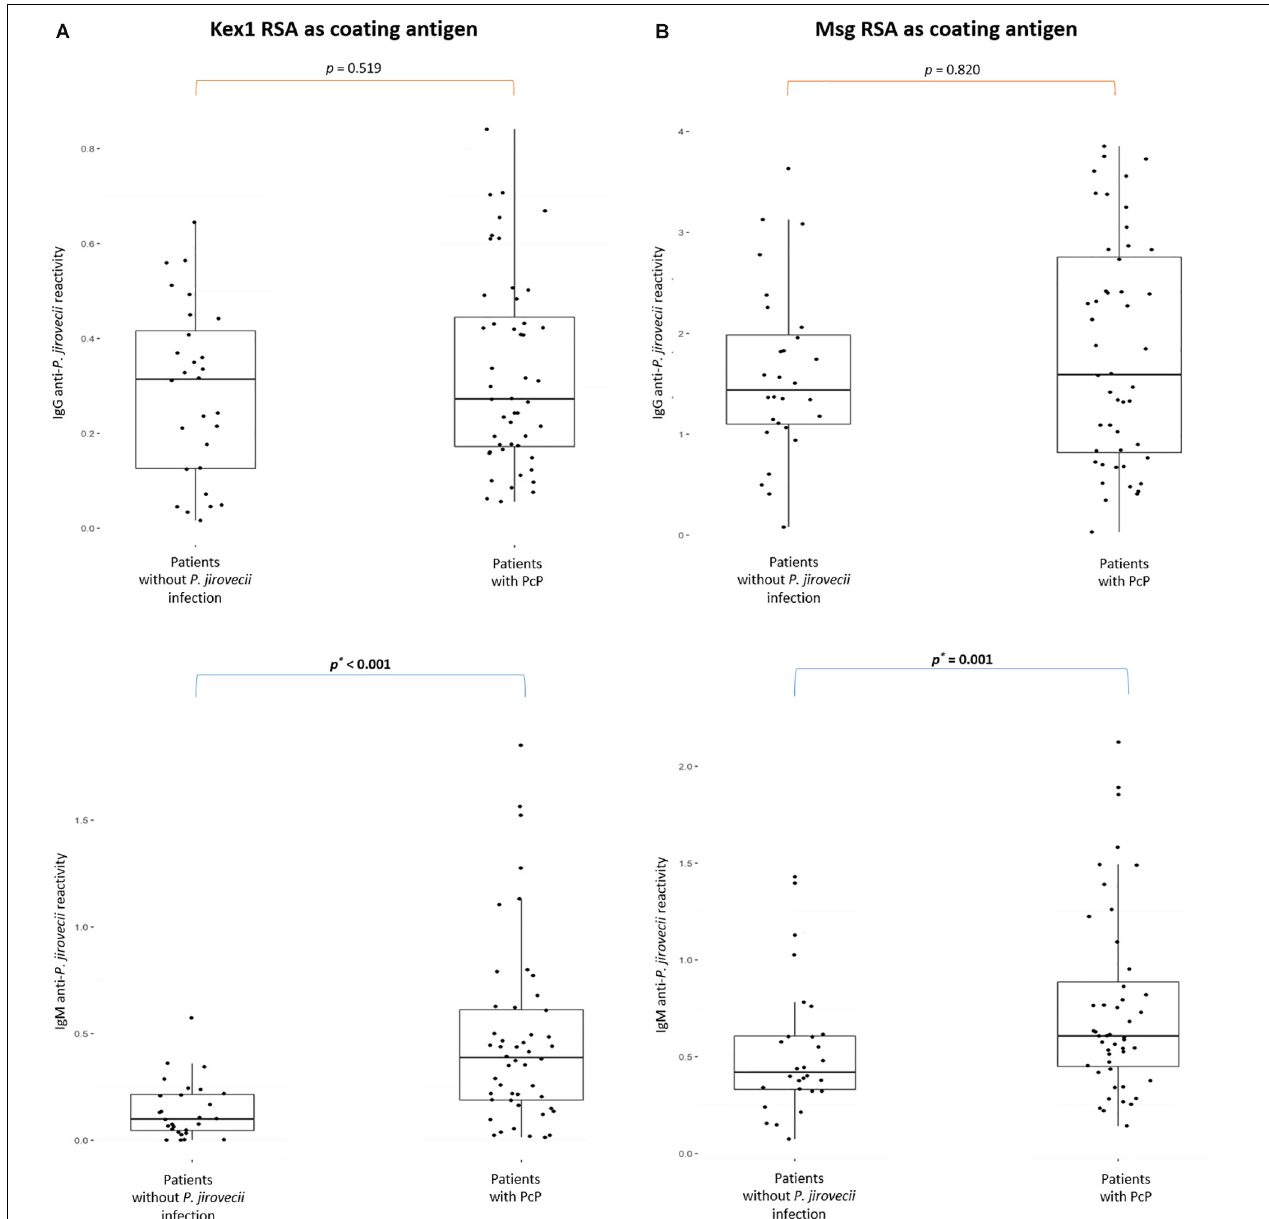
FIGURE 3 | Boxplots with IgG and IgM anti- P. jirovecii levels results across patients with PcP and patients without P. jirovecii infection. Simple boxplots showing the reactivity levels (OD at 405 nm) of IgG and IgM anti- P. jirovecii antibodies detected by ELISA protocols applied with the Kex1 RSA (A) and Msg RSA (B) as coating antigens, in all sera specimens of patients analyzed in the study. The statistic values ( p ) representing the statistical significant difference from Mann Whitney-U tests performed between patient’s groups are